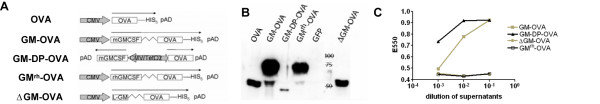
Map and characterization of vaccine constructs. (A) Expression cassettes of the indicated vaccine constructs are shown. All open reading frames are under the control of the human cytomegalovirus immediate early promoter (CMV) or its derivative (CMVtetO2). His6: C-terminal tag; L-GM: leader peptide of GM-CSF; m: murine; rh: rhesus monkey; "": [Gly4Ser]3-linker. (B) Ovalbumin-specific Western Blot analysis of supernatants of 293T cells transiently transfected with plasmids containing the indicated expression cassettes. GFP: supernatant of cells transfected with a GFP expression plasmid. (C) GM-CSF dependent FDCP-1 proliferation. 293 cells were infected with adenoviral vectors containing the indicated expression cassettes and the GM-CSF levels in the supernatants were determined 24 h post infection. Serial dilutions of the supernatants were co-cultured with FDCP-1 cells for 2 days. Proliferation was measured by a MTT assay.